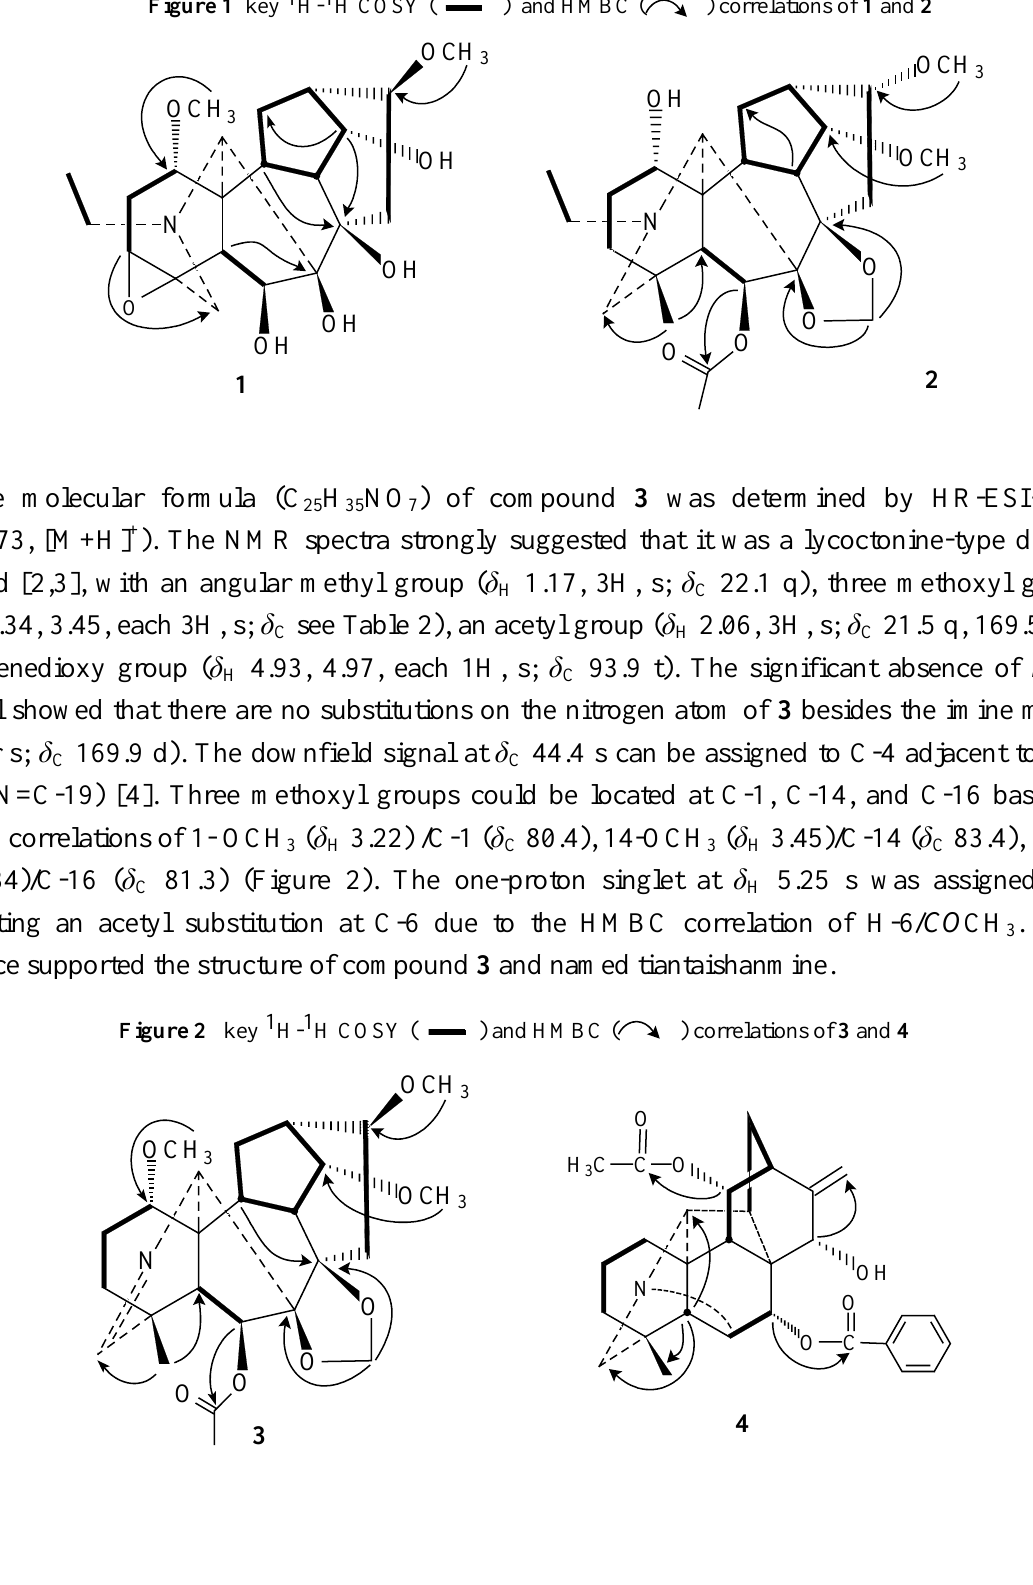
Figure 1 key 1 H-1 H COSY ( ) and HMBC ( ) correlations of 1 and 2